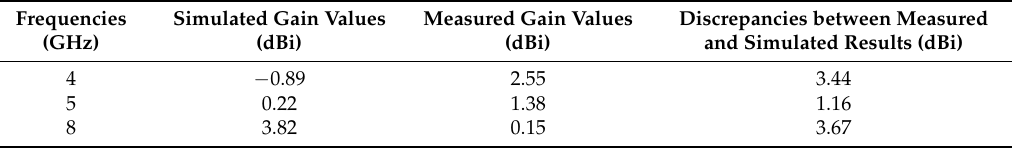
Table 3. The simulated and measured gains of the proposed antenna.